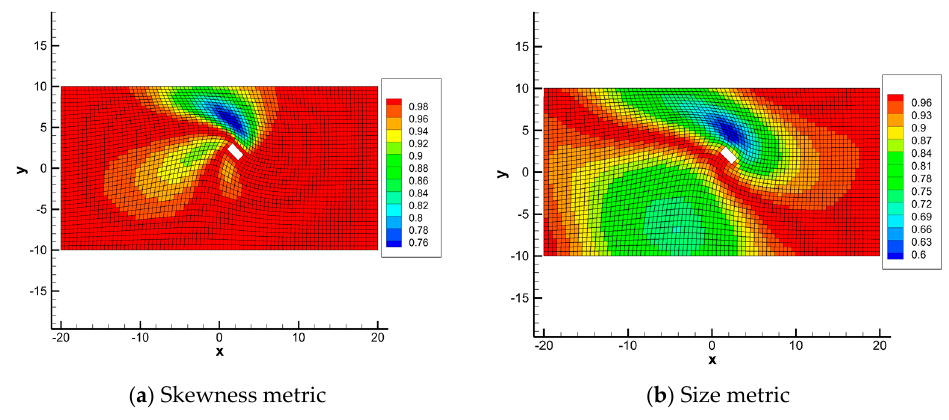
Figure 5. Geometrical configuration of the mesh element. Table 3. Comparison between the mapping-based method and geometrical method.